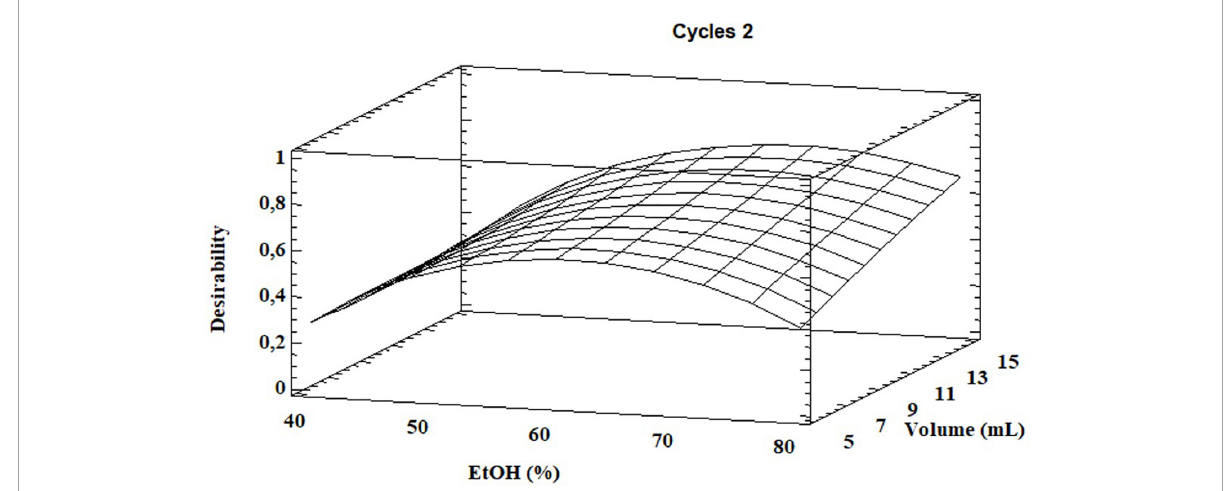
FIGURE2 Desirability plot for total glucosinolate extraction as functions of ethanol percentage and total solvent volume.